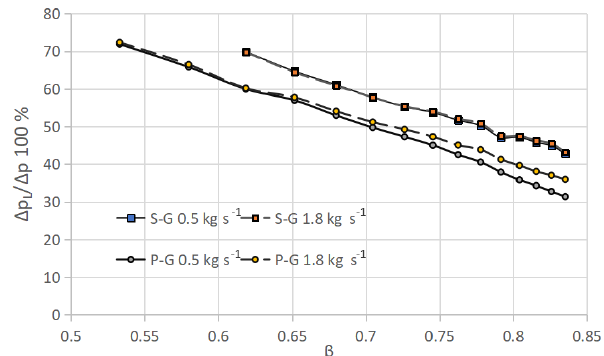
Figure 32. Permanent pressure loss percentage against β for both